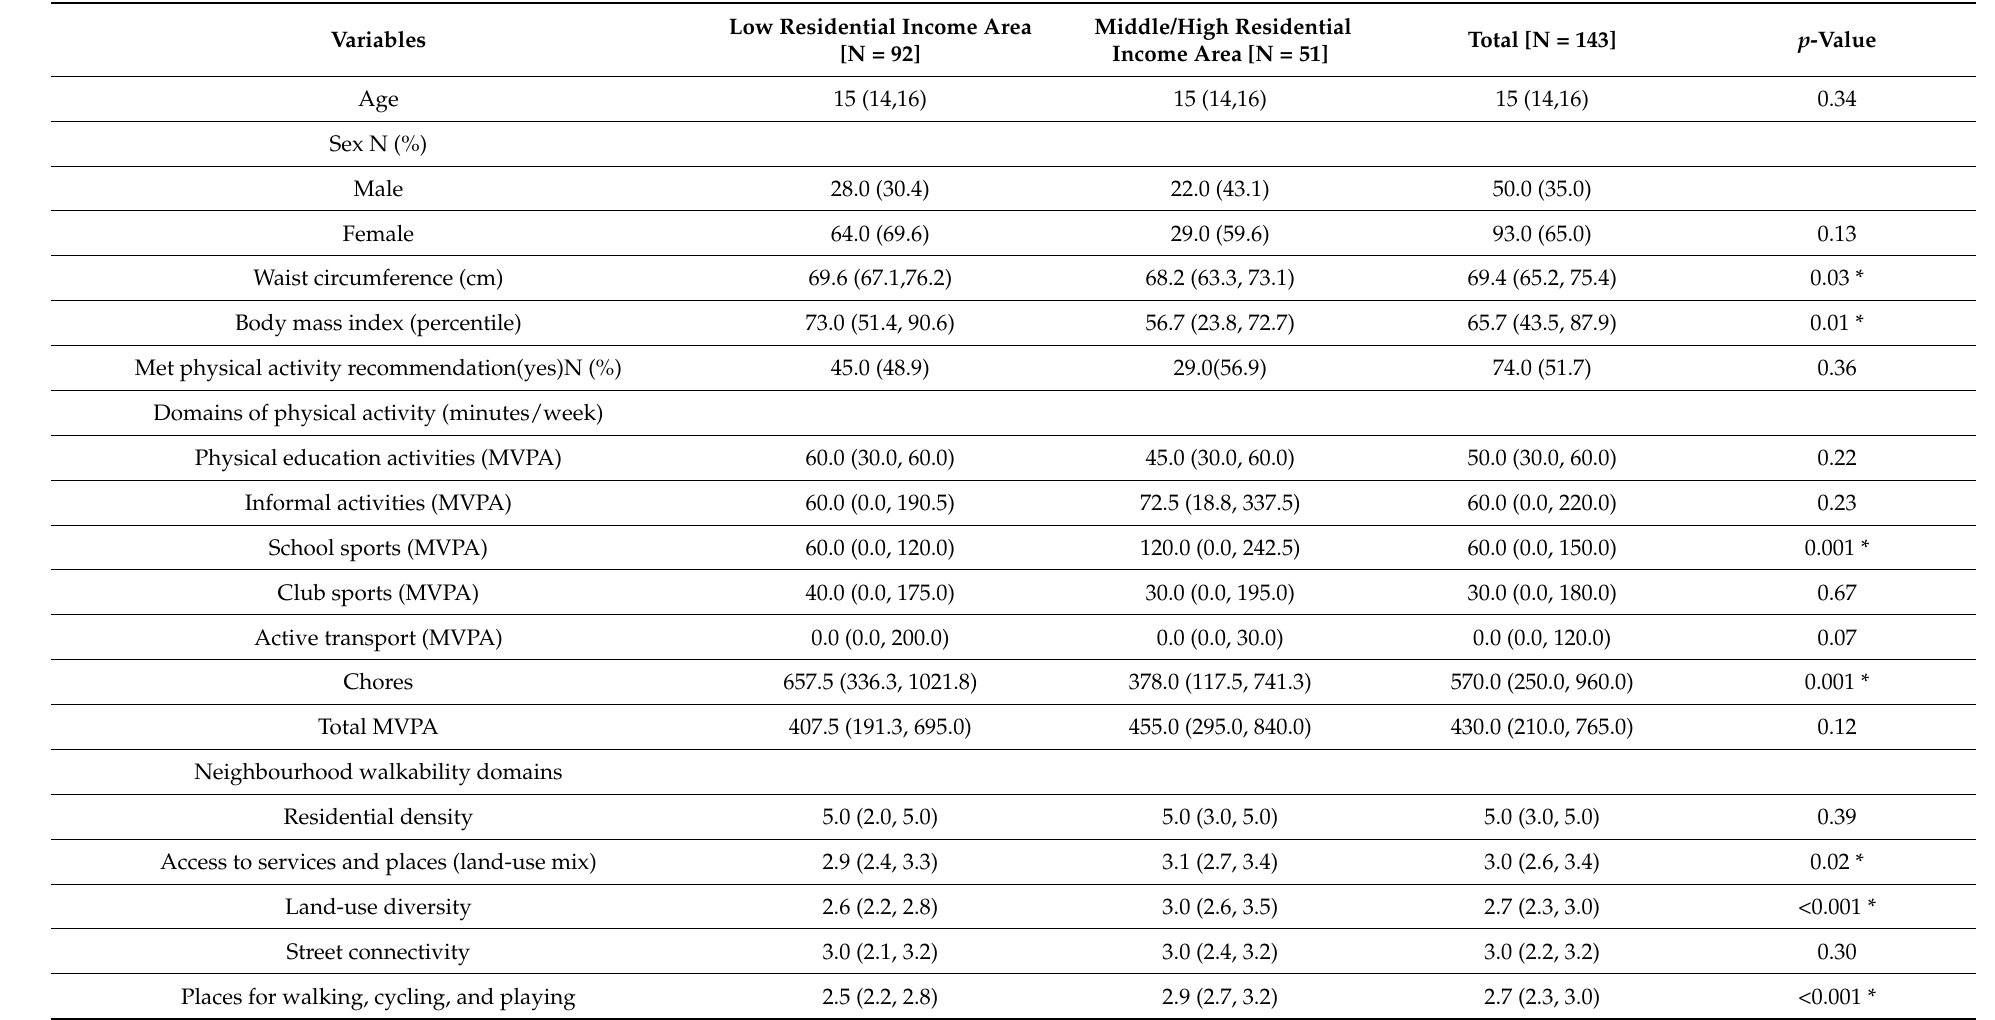
Table 1. Overall and specific study condition sample characteristics categorized by residential income